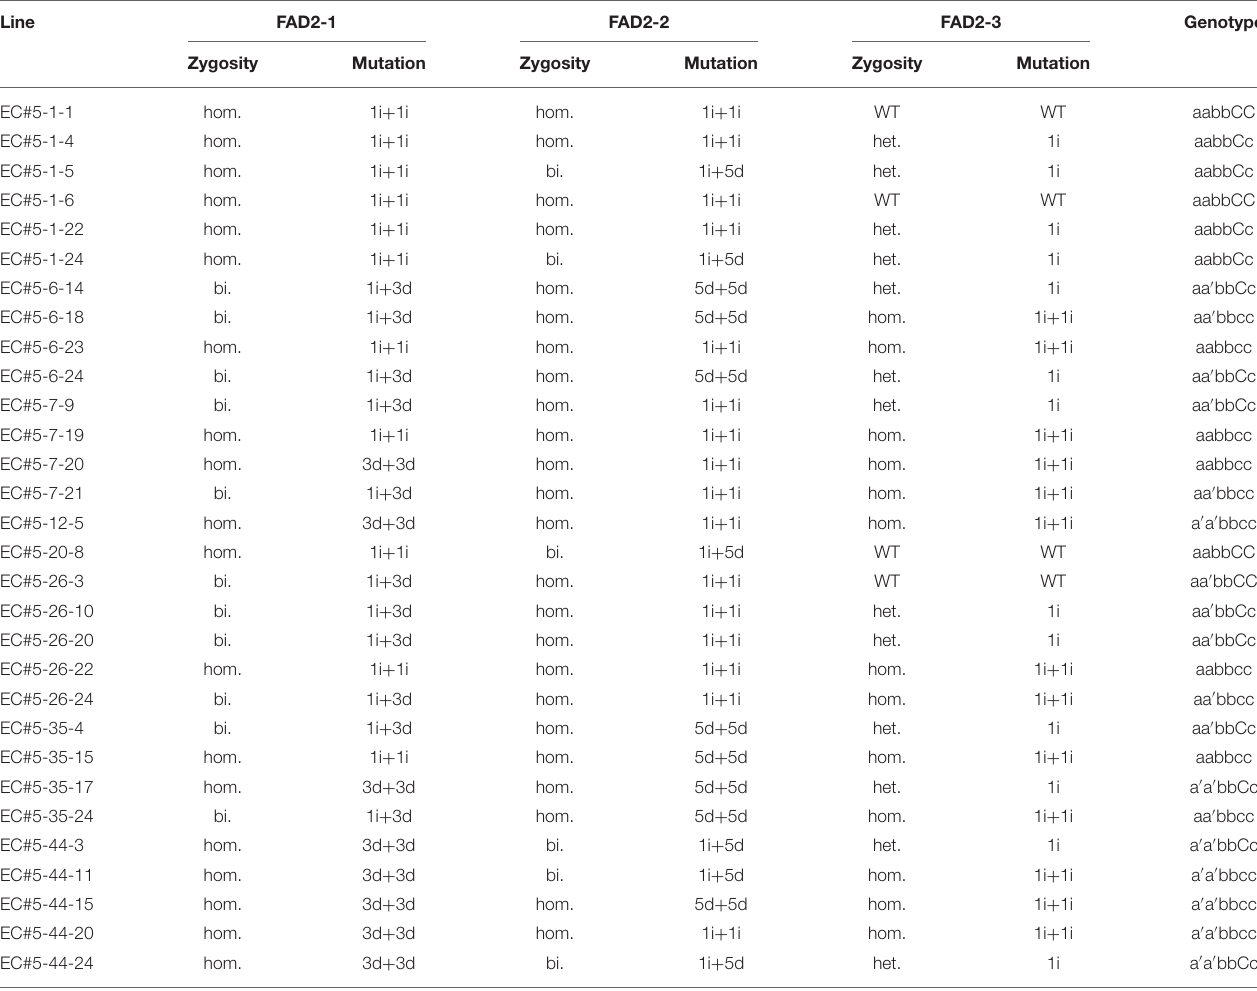
TABLE 2 | Genotypes of T 3 Camelina progenies revealed by Sanger sequencing following homoeolog-specific